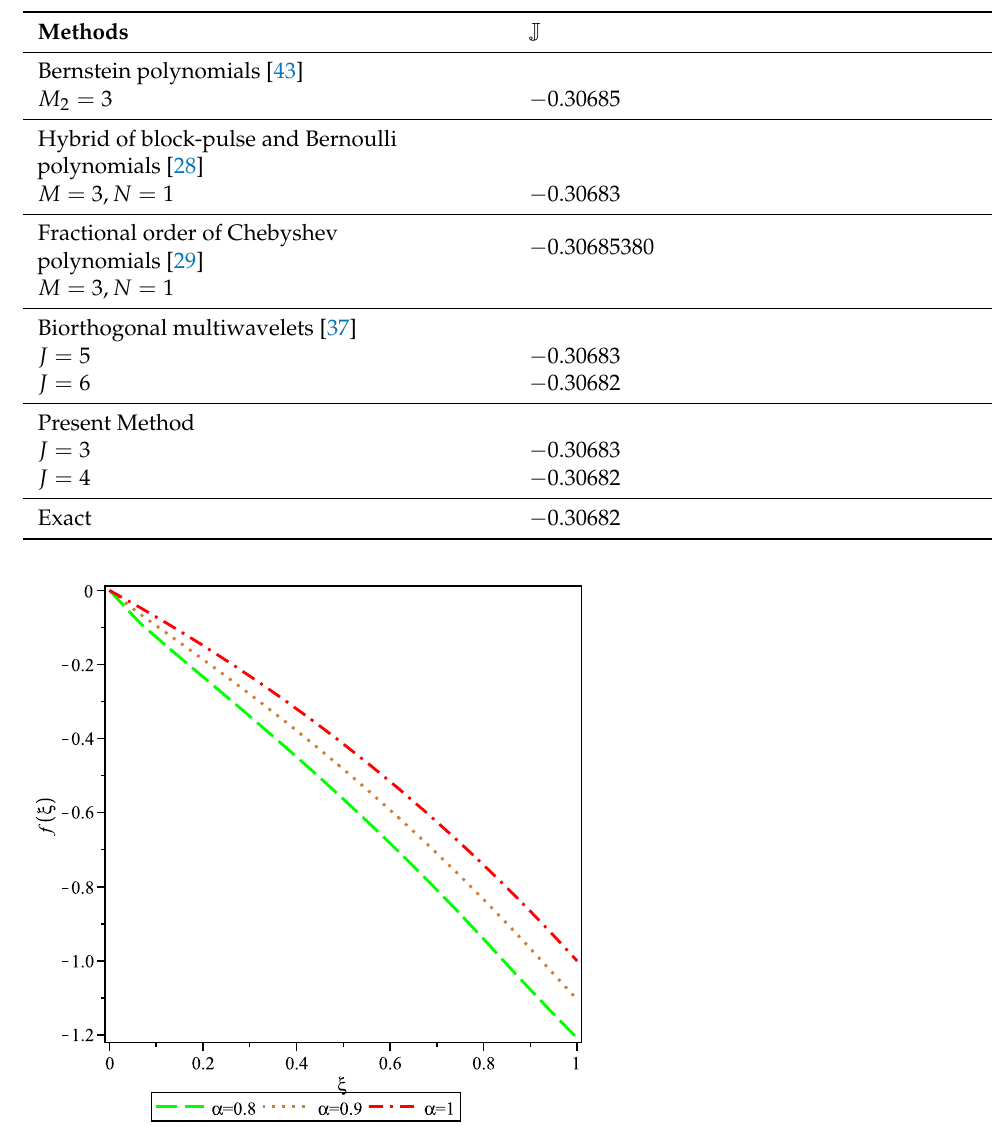
Figure 3. Approximate state and control variables for Example